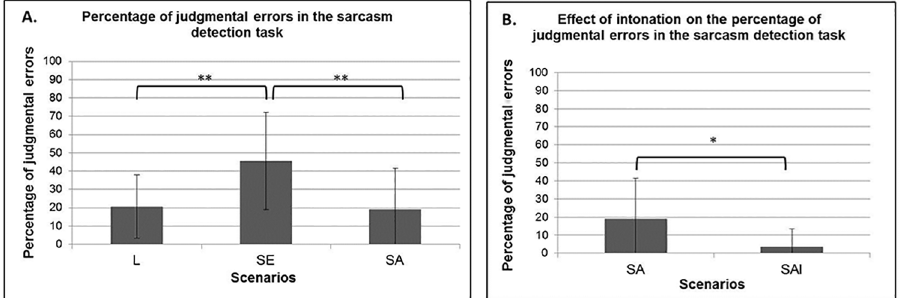
Fig 4. A. Percentage of judgmental errors for literal (L), sarcastic egocentric (SE), sarcastic allocentric (SA) scenarios. B. Percentage of judgmental errors for sarcastic allocentric (SA) and sarcastic allocentric with intonation (SAI) scenarios. * = p (cid:1) .01, ** = p (cid:1) 0.005; *** = p <